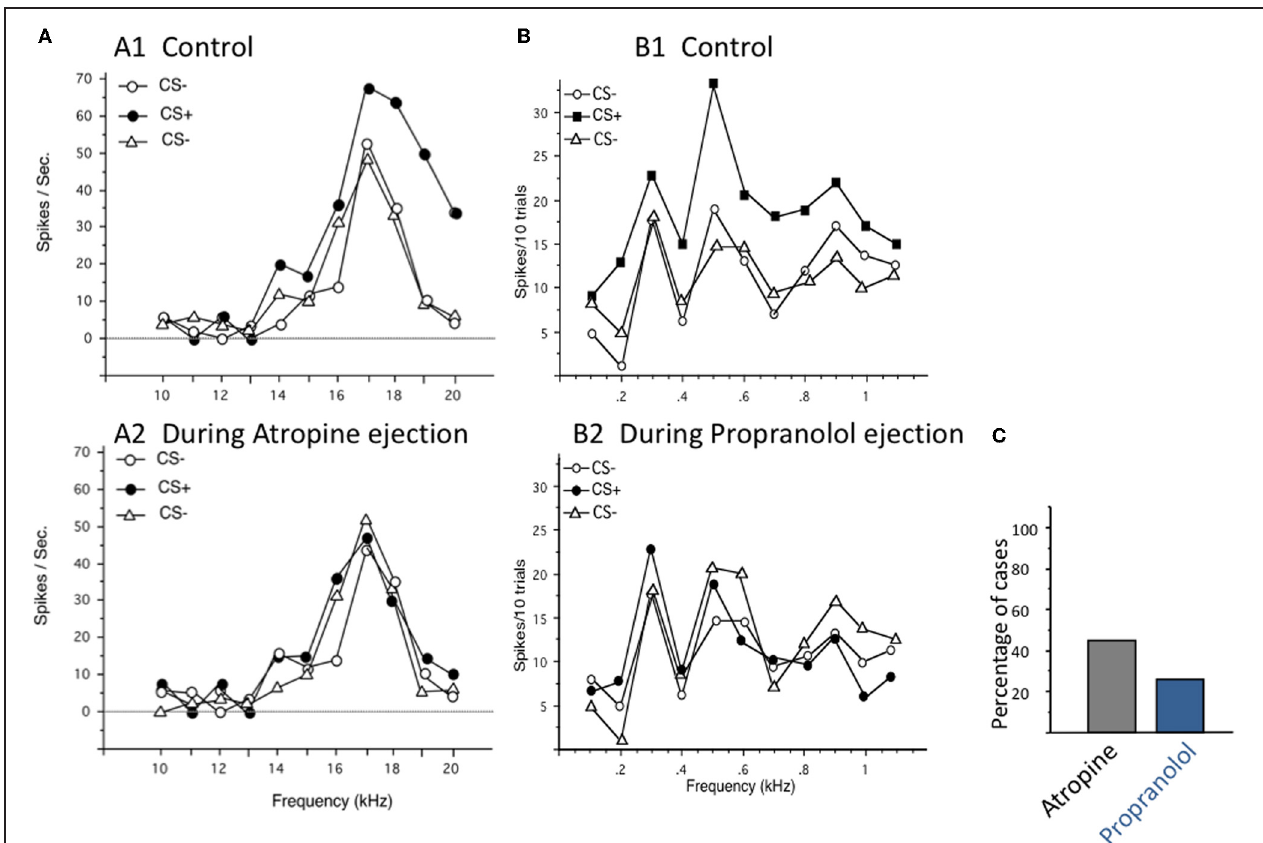
FIGURE 5 | Task-related changes in firing rate can be blocked either by cholinergic or by noradrenergic antagonists. In that protocol, the pure tones used to determine the frequency tuning curves also constituted the acoustic CS + and CS − depending on whether they were preceded by a flashing light (for the CS + )or not. Animals were trained until they reached 90% of responses (bradycardia) to the CS + and less than 40% of response to the CS − . During off-line tests, single unit recordings were performed in primary auditory cortex at presentation of sequences of CS − /CS + /CS − trials in normal conditions (control), then in the presence of continuous iontophoretic ejections of neuromodulators antagonists. (A) Blockage of facilitation by the muscarinic antagonist Atropine. A1. For this cell, the responses obtained in the neuron’s frequency receptive field were largely facilitated from 14 to 20kHz during the CS + trials (i.e., when the flashing light was presented before the pure tones). When the same sequence of CS − /CS + /CS − was